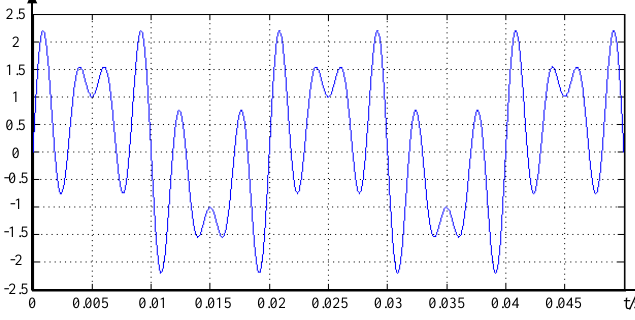
Figure 6. Modulated waveform after injection of harmonics.